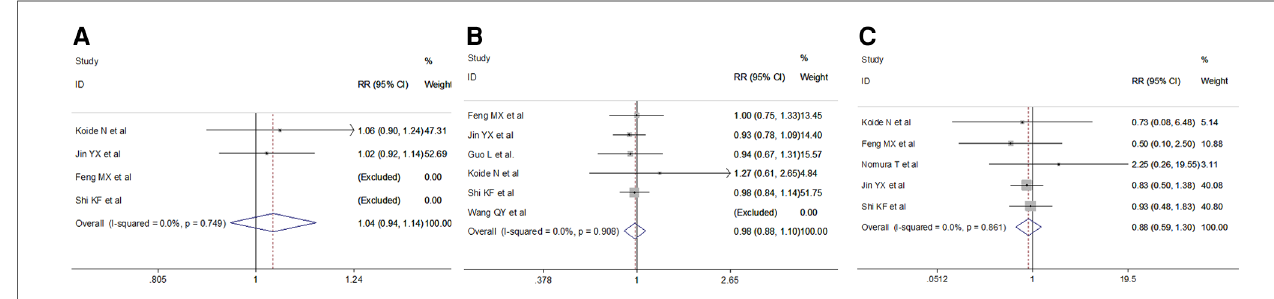
FIGURE 4 Meta-analysis of pathological features: ( A ) Pathology; ( B ) Stage; ( C ) Tumor